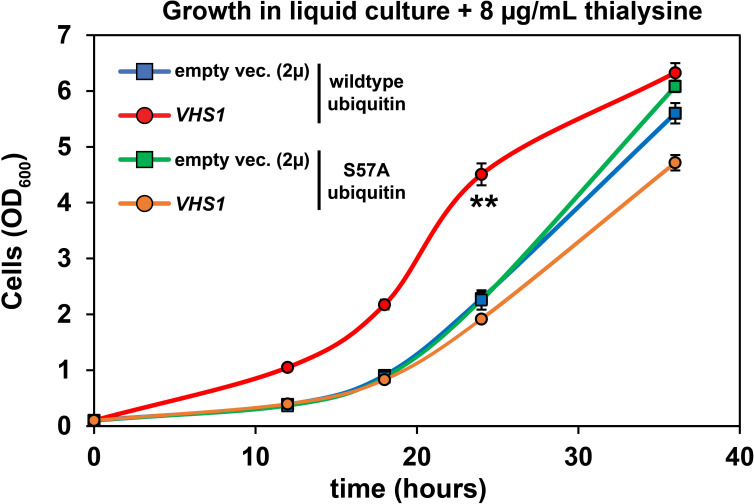
Analysis of cell tolerance to thialysine of yeast cells overexpressing VHS1.Vhs1 (cloned into a 2µ multicopy plasmid pRS327) was overexpressed in SUB280 cells expressing ubiquitin (exclusively wildtype or S57A). Cells were grown in lysine dropout synthetic liquid media supplemented with 8 µg/mL thialysine. Values at each time point are means of four biological replicates with ± SD expressed as error bars. Double asterisk (**) indicates p value < 0.001 at the 12, 18, and 24 hr time points using a Student’s t-test, which was only observed for yeast overexpressing wildtype VHS1 in the context of wildtype ubiquitin expression. For all statistical analysis associated with this figure supplement, p values are reported in the Figure 4—source data 1.